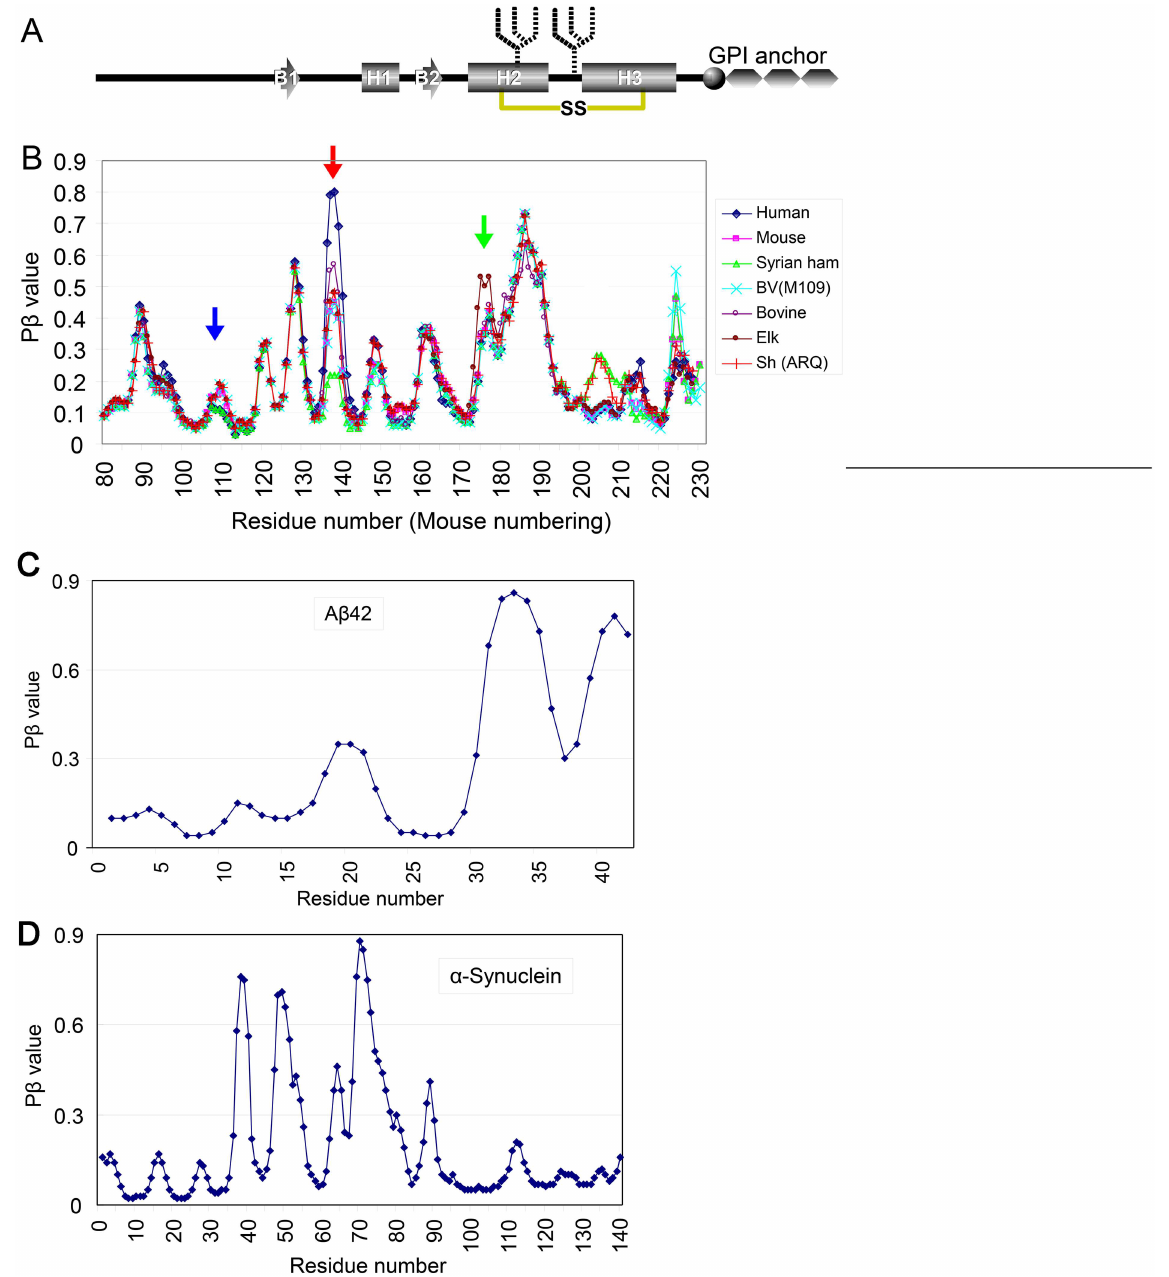
Fig 1. P β graphs of PrP of representative species look very alike but with certain differences. A . Schematic illustration of the secondary-structure componentsof prion protein (PrP) and post-translationalmodifications, includingdisulfidelinks (yellowline with "SS"), N-linkedglycans (fork-like objects) and glycosylphosphatidylinositol anchor (GPI anchor). B1 and B2, the first and the second β -strands, respectively. H1, H2 and H3, the first, second and third α -helices,respectively. B . P β graphs of PrP from variousspecies. The blue, red and green arrows indicatepeaks centered at residues 110, 140 and 175, respectively.Syrian ham, Syrian hamster; BV (109M), bank vole with methionine at residue 109 (in bank-volenumbering);Sh(ARQ), sheepwith the A136/R150/Q171 polymorphism. C and D . P β -graphsof A β 42 and human α -synuclein, respectively.